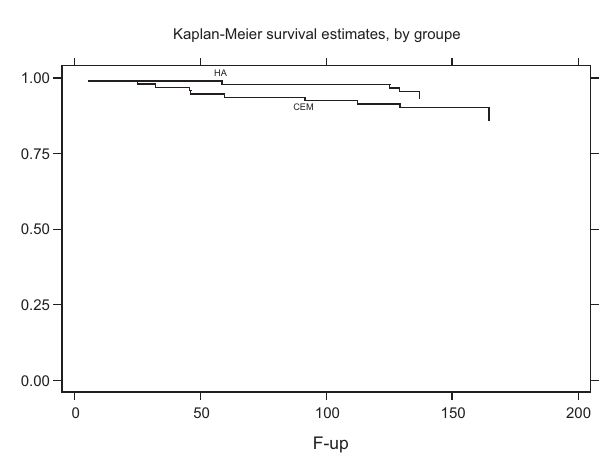
Figure 5. Survival